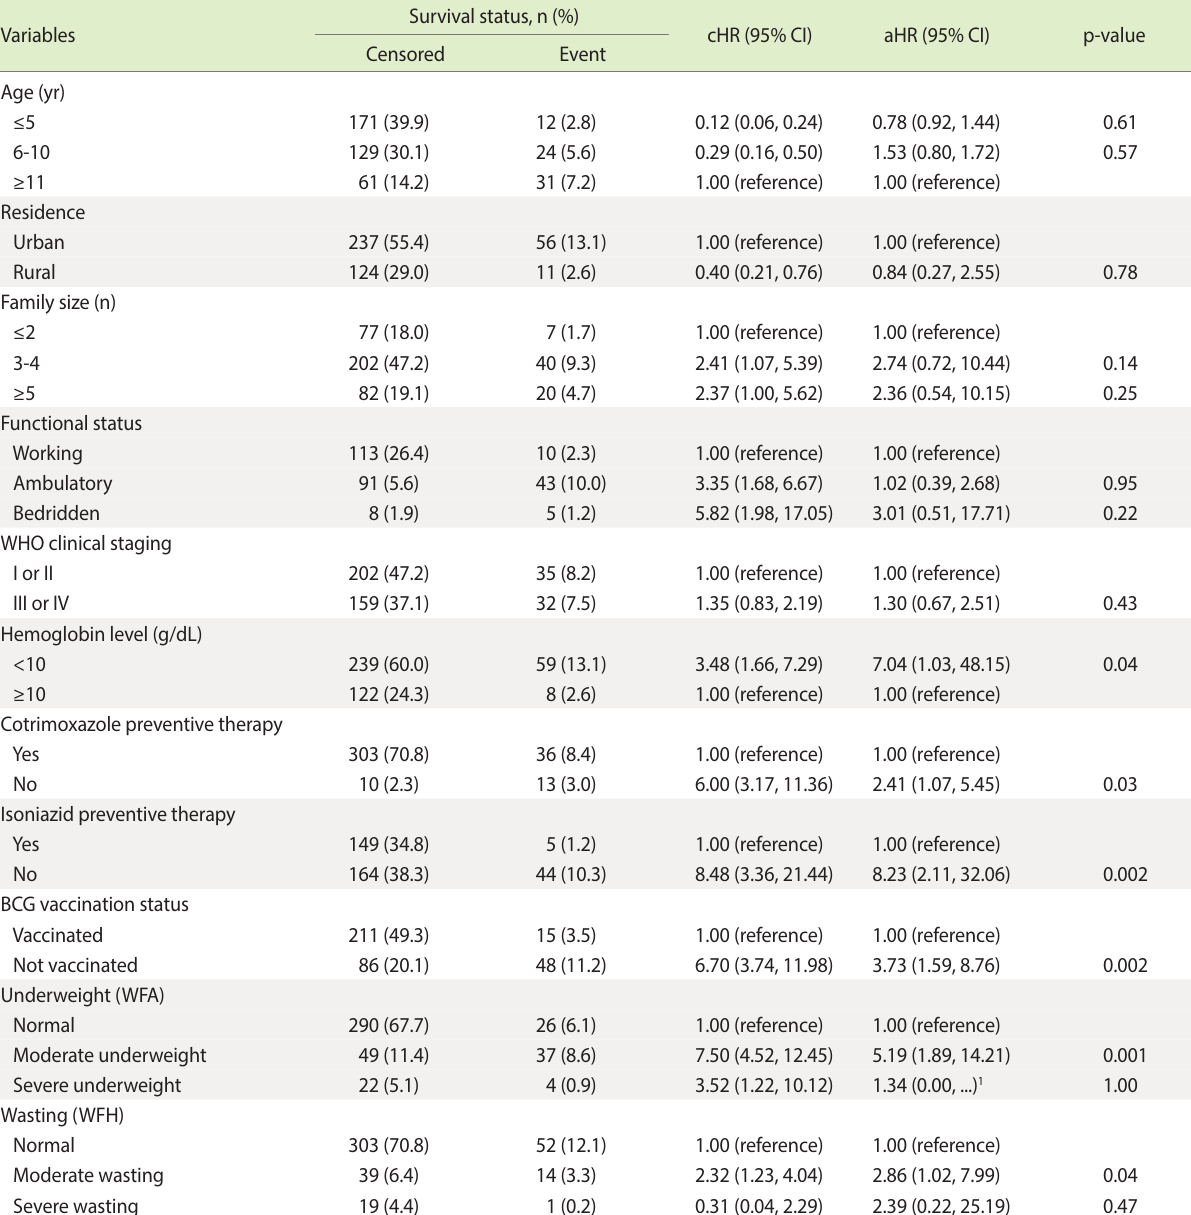
Table 4. Bivariate and multivariable Cox regression proportional hazards regression analysis of predictors of tuberculosis incidence among HIV-infected children at Adama Referral Hospital and Medical College